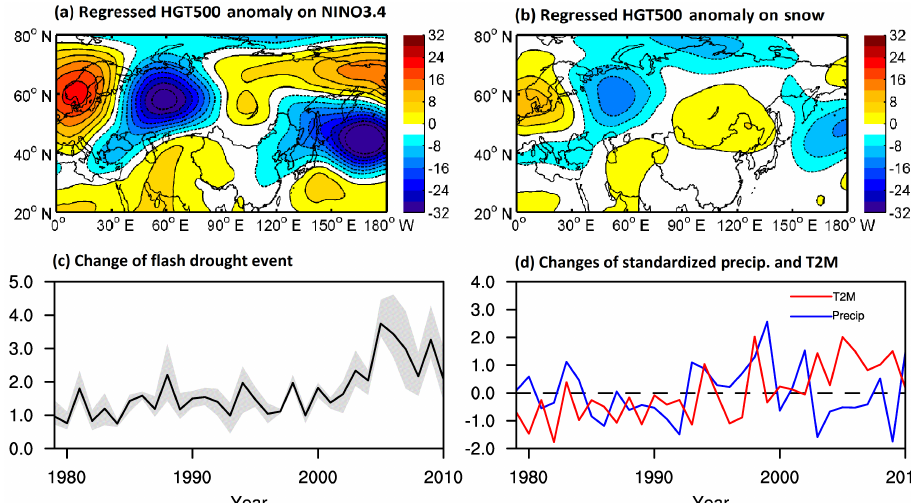
Figure 7. Joint analysis of a variety of climate variables provides new insights into the predictability of seasonal drought in China and into recent changes in the character of flash drought there. The top panels show (a) the slopes (in geopotential meters, or gpm) of the regressions of July–August 500hPa geopotential height anomaly on detrended (and standardized) July NINO3.4 index and (b) the slopes (also in gpm) of the regressions of this height anomaly on negative (and standardized) March Eurasian snow cover. The two panels demonstrate that both ENSO and Eurasian snow cover are statistically tied to the Eurasia teleconnection (EU) pattern responsible for summer droughts in northern China (modified from Wang et al., 2017). Note that a seasonal climate forecast model usually shows higher forecast skill during ENSO years; the CFSv2 model, for example, predicted the 2015–2016 El Niño and roughly captured the devastating North China drought in the summer of 2015. However, a strong El Niño does not necessarily result in an extreme drought in North China, since such drought also depends on whether the El Niño evolves synergistically with Eurasian spring snow cover reduction to trigger a positive summer Eurasian teleconnection (EU) pattern (a–b) that favors anomalous northerly air sinking over North China; see Wang et al. (2017) for more information. Regarding changes in the character of flash drought, the two bottom panels show (c) changes in flash drought events (events per year) over southern China and (d) changes in standardized (and thus dimensionless) precipitation and surface air temperature averaged over southern China. The increasing trend in flash drought over southern China suggests that the probability of concurrent heat extremes, soil moisture deficits, and positive evapotranspiration anomalies there is increasing; see Wang et al. (2016) for more information. (Contact: Xing